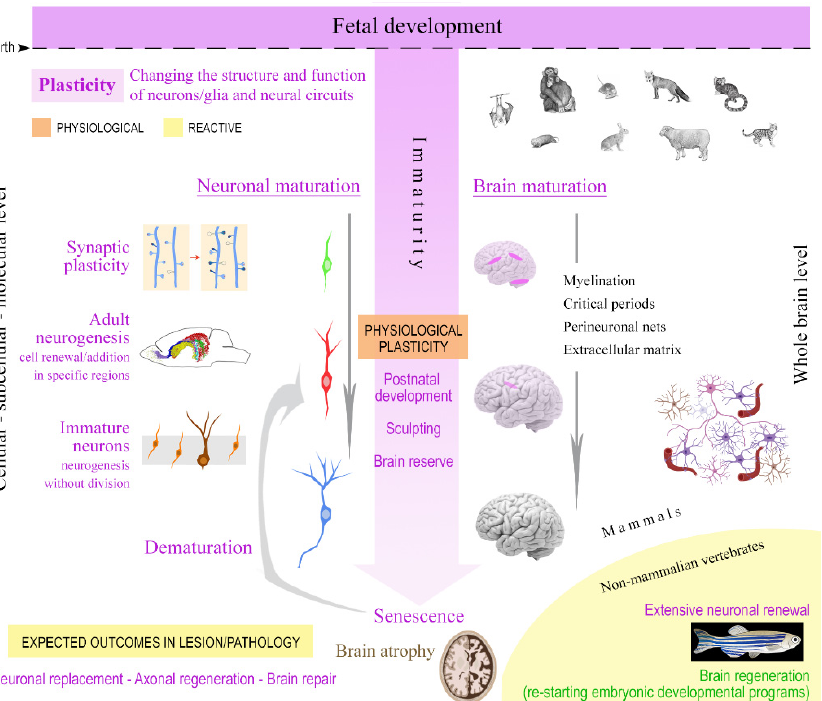
Figure 1. There are different types of structural plasticity which are linked to neuronal and brain immaturity. On the left are listed the main types of plasticity considered at a cellular/subcellular level (from the small modifications of synaptic contacts between pre-existing neurons to different types of “addition” of neuronal elements). On the right, the same processes are viewed at the whole brain level across the lifespan, determining differential maturation of various neural systems/circuits (brain regions) with remarkable differences depending on the animal species. Most of the naturally occurring plasticity plays a “physiological” role in brain postnatal development/sculpting and adaptation (center). Bottom, possible outcomes after lesion/disease (reactive plasticity) are limited in mammals, the main role of brain immaturity/plasticity being related to the postnatal brain development. A substantial difference in brain regeneration capability exists between mammals and non-mammalian vertebrates.